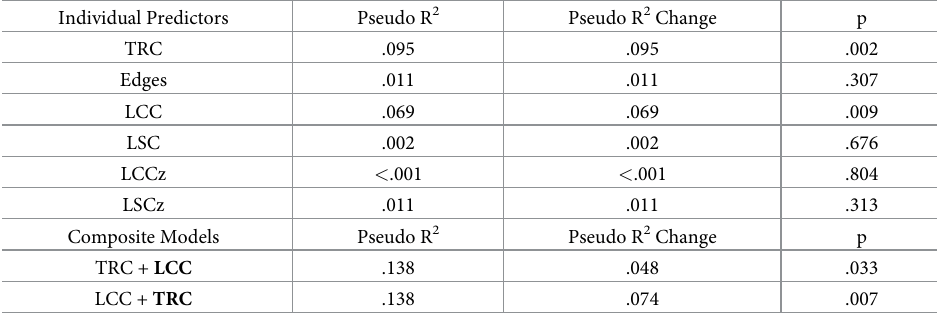
Table 3. Results from generalised linear mixed models in predicting sleep stage.